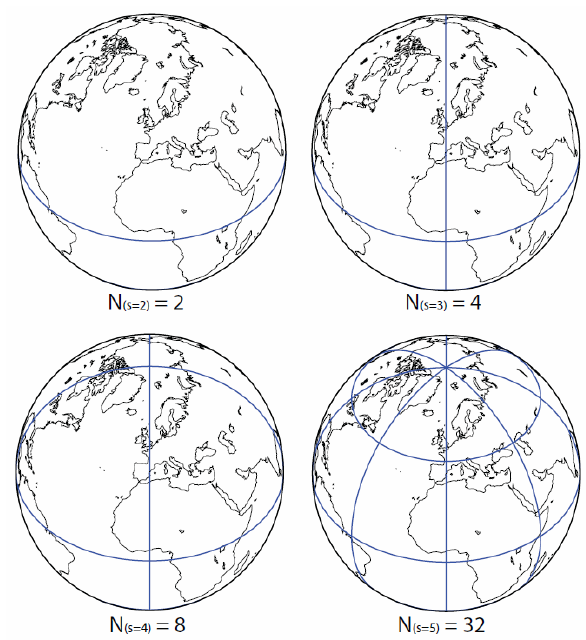
Fig. 4. Second to fifth step of the algorithm cutting the surface of the Earth in individual areas. N is the number of areas delimited by the bluetraight lines, and s the step in the algorithm. The surface temperature time series are averaged over all the individual areas to calculate the SNR.